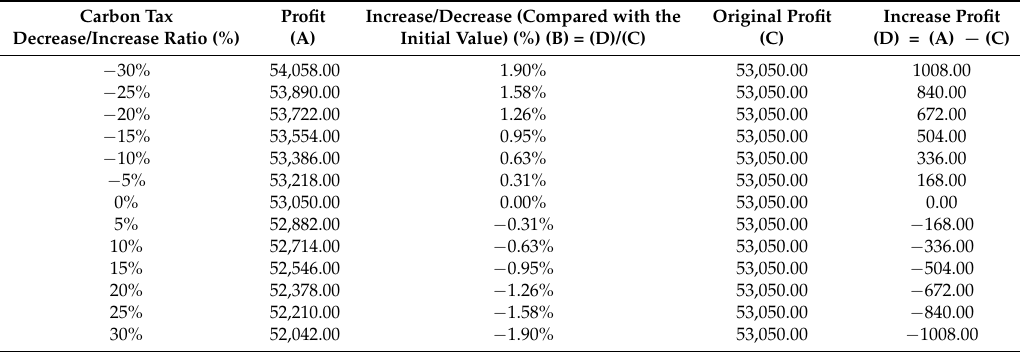
Table 7. Sensitivity analysis on the carbon tax of model